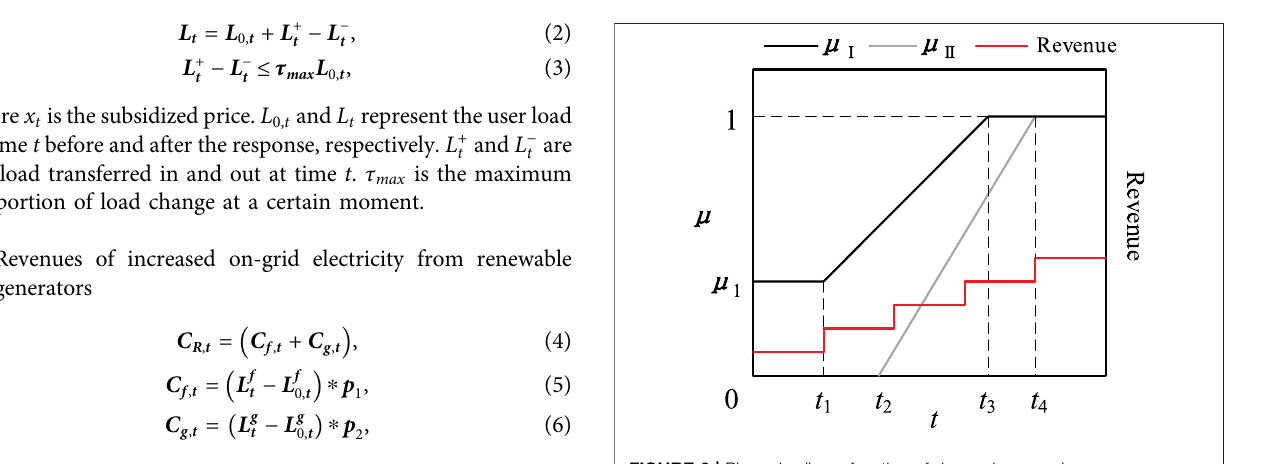
FIGURE 2 | Piecewise linear function of demand